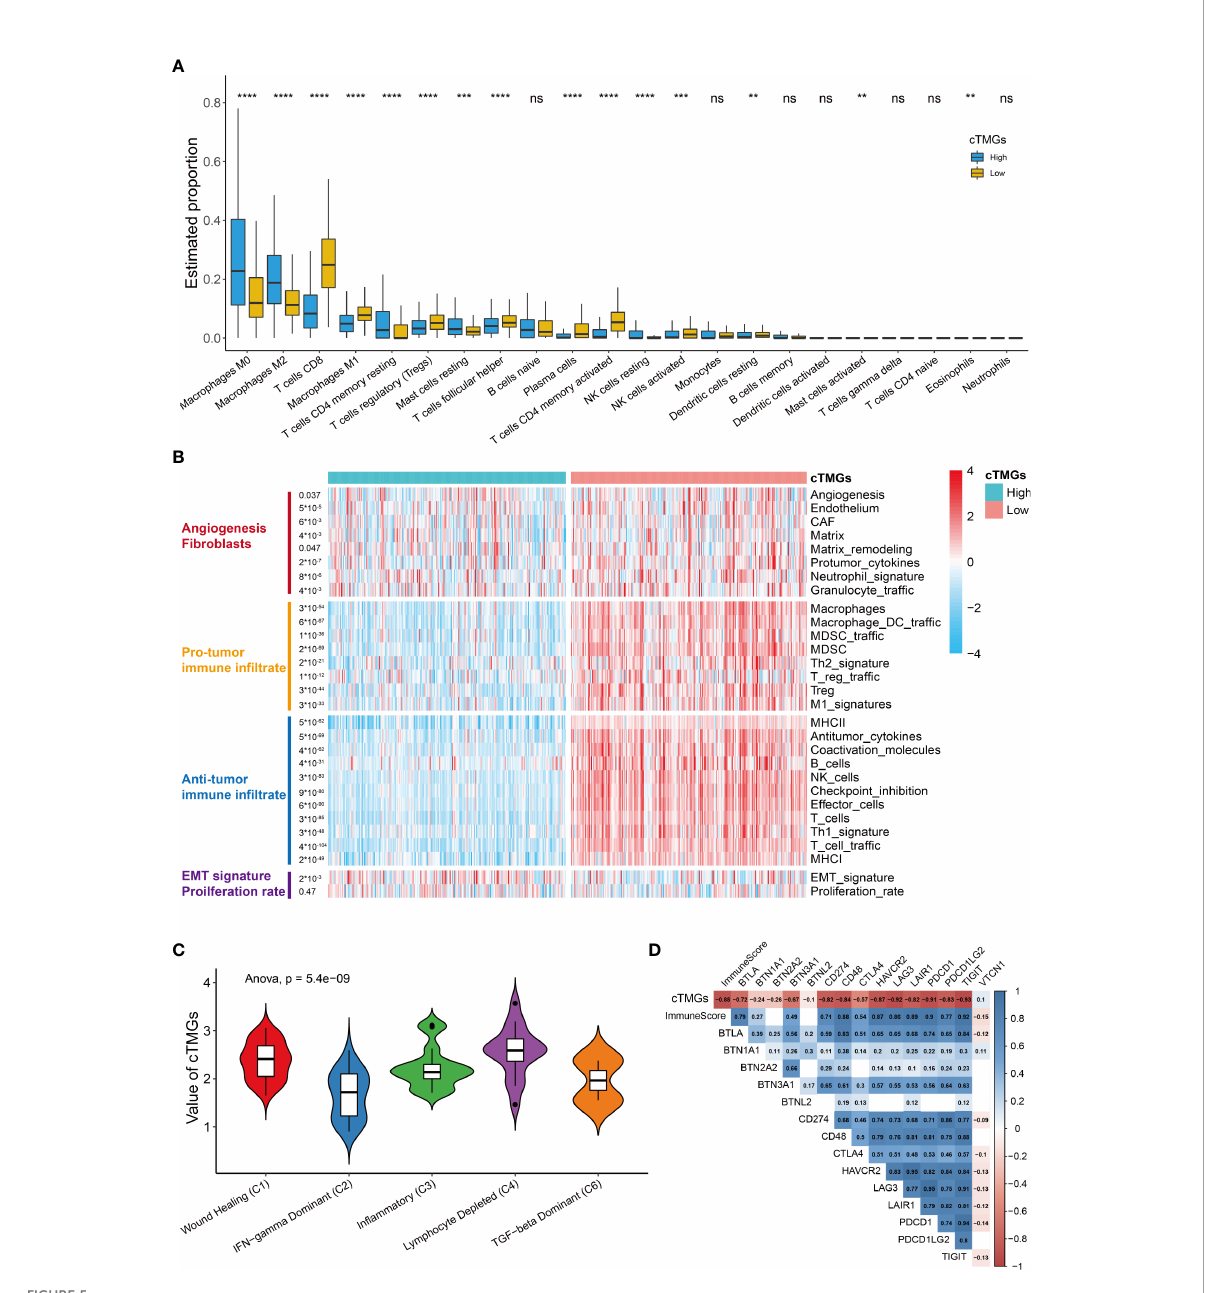
FIGURE 5 Immune in fi ltration in high- and low-cTMGs CM. (A) Distribution of in fi ltrating immune cells in high- and low-cTMGs groups CM. (B) Heatmap showed the 29 Fges in CM patients in the TCGA_SKCM dataset. (C) Box plot showing a difference in the value of cTMGs across the fi ve subtypes for CM patients in the TCGA_SKCM dataset. (D) Heatmap shows the correlation between cTMGs and the expression levels of immune checkpoints *p < 0.05; **p < 0.01; ***p < 0.001; ****p < 0.0001. ns for no signi fi